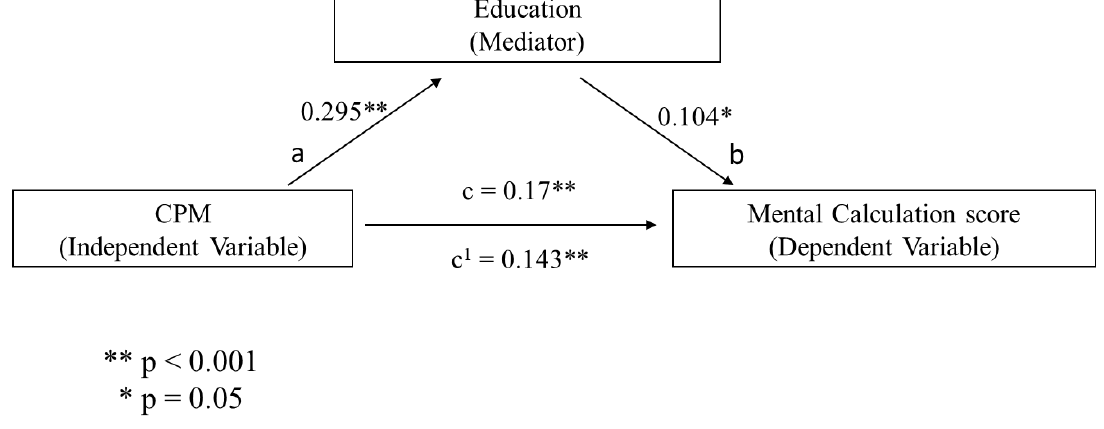
Figure 2. The predicted mediational pattern for Mental Calculation using CPM as the independent variable and vocabulary knowledge as mediator. Figure 3. The predicted mediational patterns for Mental Calculation using vocabulary knowledge as the independent variable and educational attainment as mediator.